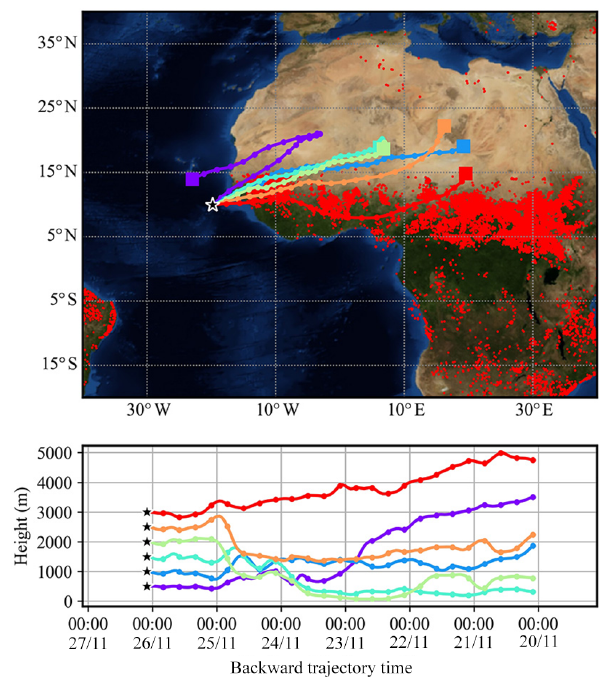
Figure 7. NOAA HYSPLIT backward trajectories arriving at RV Polarstern (black star with white border, 10.04 ◦ N, 19.82 ◦ W) on 26 November 2018 at 02:00UTC. Red dots are the fire spots de- tected by MODIS aboard the Terra and Aqua satellites over the pe- riod from 20 to 26 November